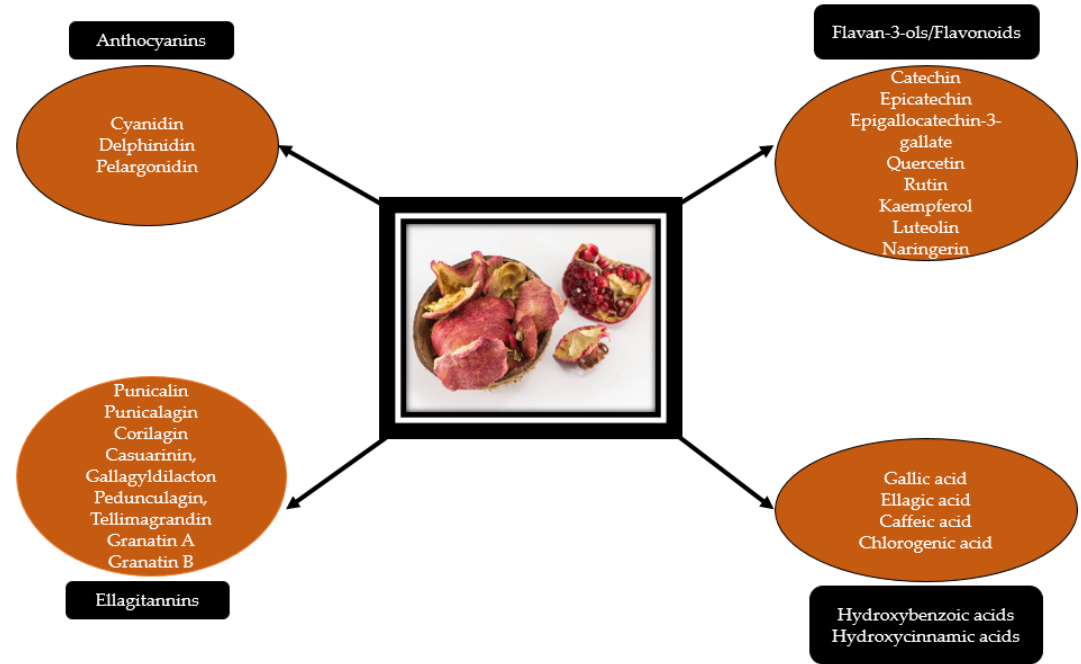
Figure 2. Chemical composition of pomegranate peels.